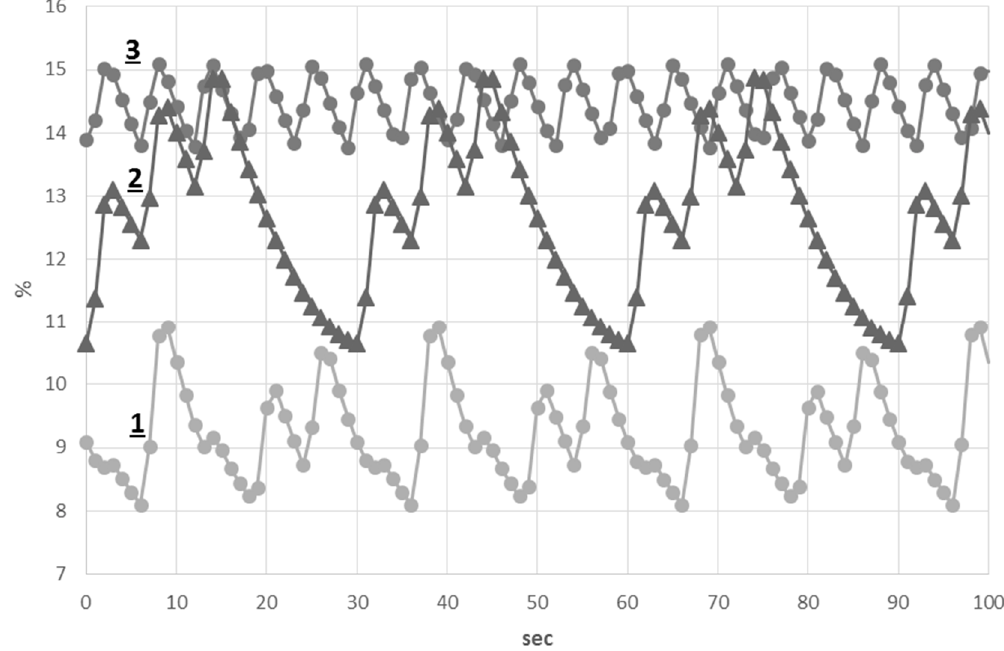
O : (1) Periodic breathing; (2) Cluster breathing; (3) normal Figure 6. Alveolar concentration of Figure 6. Alveolar concentration of O 2 : (1) Periodic breathing; (2) Cluster breathing; (3) normal 2 breathing.